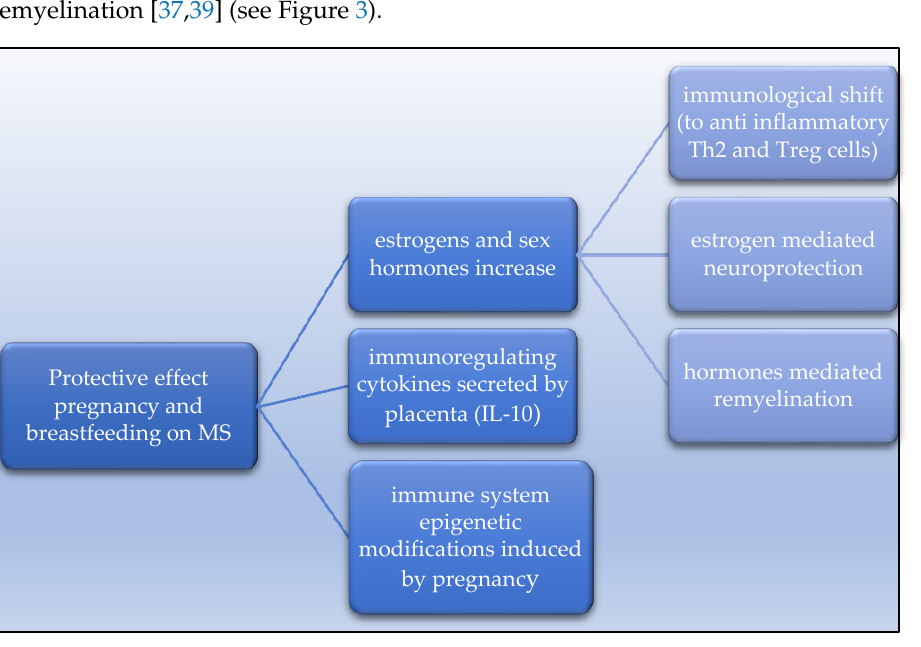
Figure 3. Mind map-like figure of the possible biological mechanisms that contribute to the potential protective role of pregnancy and breastfeeding in MS.